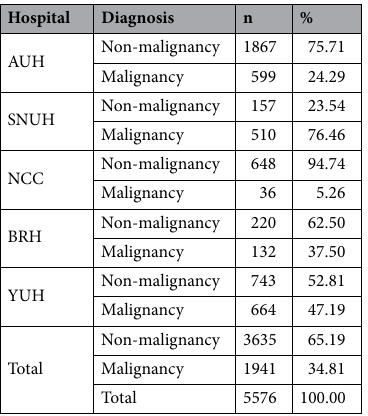
Table 1. Dataset characteristics. AUH Ajou University Hospital, SNUH Seoul National University Hospital, NCC National Cancer Center, BRH Boramae Medical Center, YUH Yonsei University